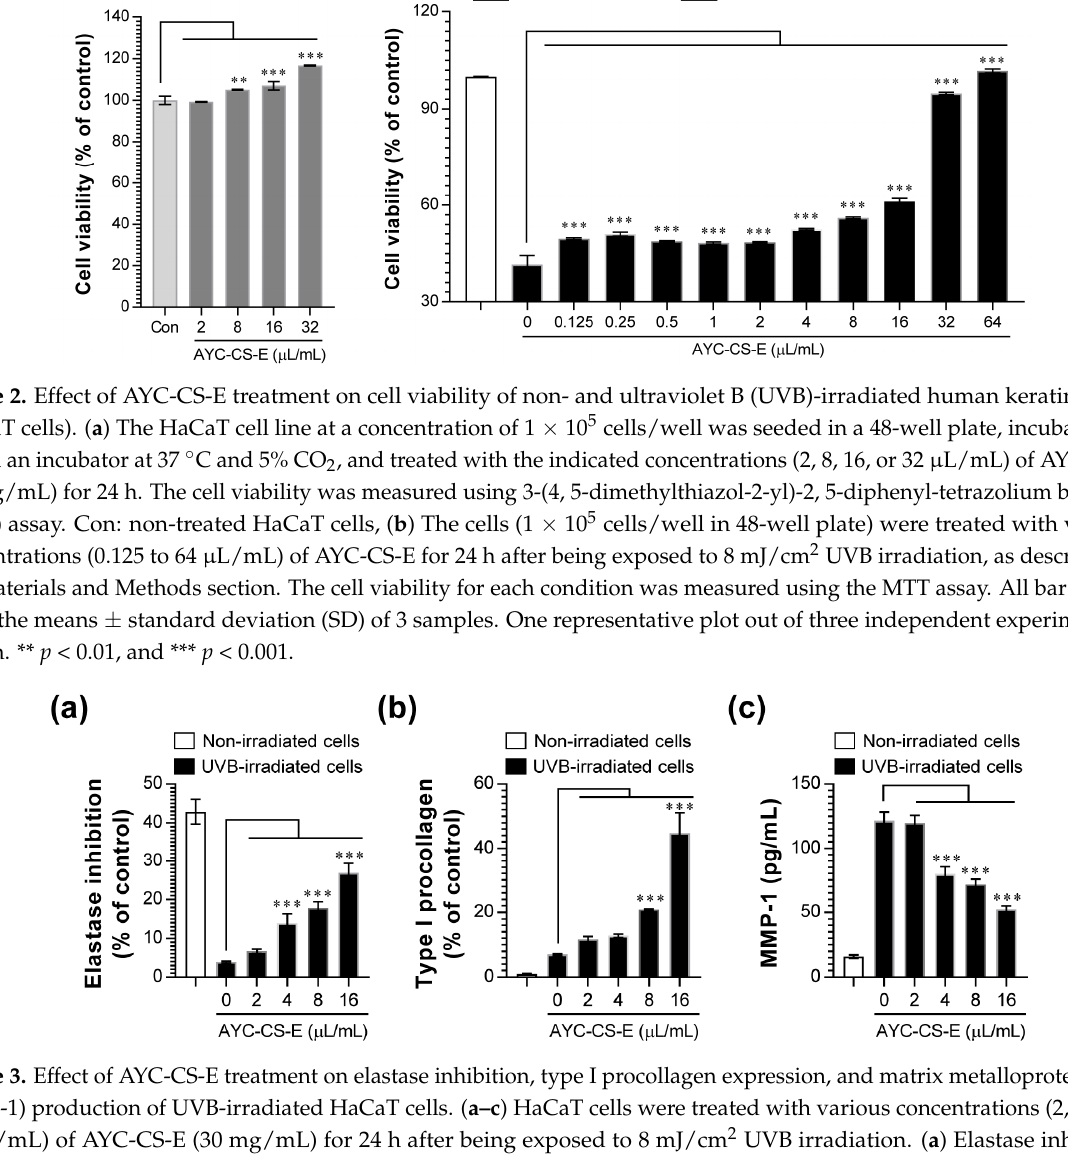
Figure 3. Effect of AYC-CS-E treatment on elastase inhibition, type I procollagen expression, and matrix metalloproteinase-1 (MMP-1) production of UVB-irradiated HaCaT cells. ( a–c ) HaCaT cells were treated with various concentrations (2, 4, 8, or 16 μ L/mL) of AYC-CS-E (30 mg/mL) for 24 h after being exposed to 8 mJ/cm 2 UVB irradiation. ( a ) Elastase inhibition levels were measured in each condition via elastase substrate (N-STANA; N-succinyl-tri-alanyl-p-nitroanilide) treatment, as described in the Materials and Methods section. Type I procollagen ( b ) and MMP-1 ( c ) levels in the culture supernatants were analyzed using enzyme-linked immunosorbent assay (ELISA) kits. All bar graphs show the means ± standard deviation (SD) of 3 samples. One representative plot out of three independent experiments is shown. *** p < 0.001.